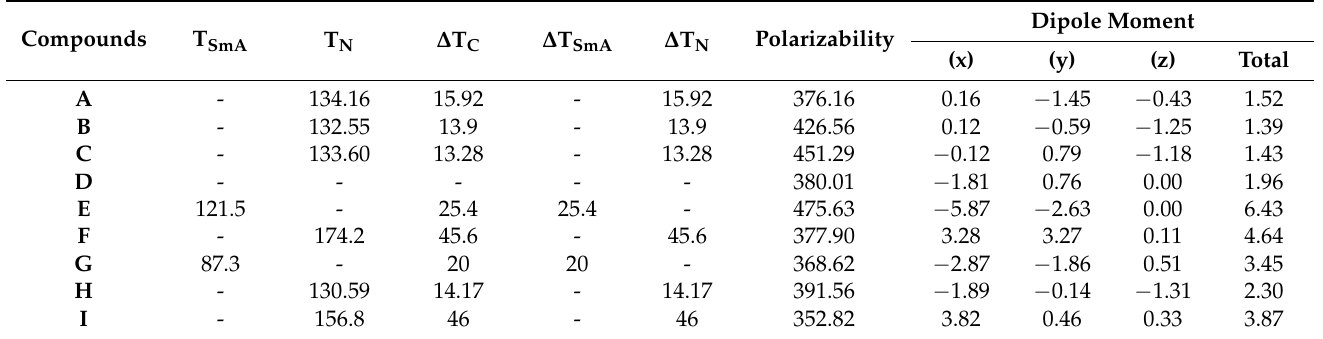
Table 4. Mesomorphic parameters for heating cycle ( ◦ C), polarizability (Bohr), and dipole